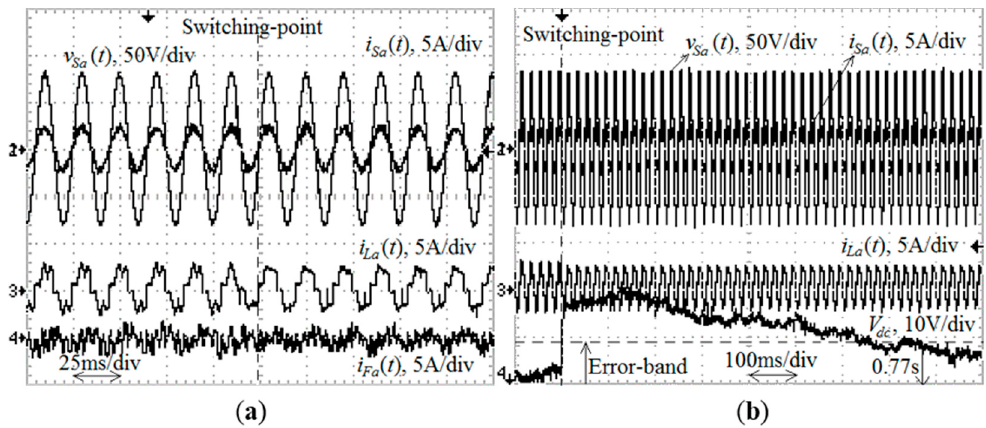
Figure 19. Experimental dynamic ‐ state ( a ) (cid:1874) (cid:3020),(cid:3036)(cid:3028) (cid:4666)(cid:1872)(cid:4667) , (cid:1861) (cid:3020),(cid:3036)(cid:3028) (cid:4666)(cid:1872)(cid:4667) , (cid:1861) (cid:3013),(cid:3036)(cid:3028) (cid:4666)(cid:1872)(cid:4667) , (cid:1861) (cid:3007),(cid:3036)(cid:3028) (cid:4666)(cid:1872)(cid:4667) , and ( b ) 3 ‐ phase (cid:1861) (cid:3020) (cid:4666)(cid:1872)(cid:4667) Figure 19. Experimental dynamic-state ( a ) v S , ia ( t ) , i S , ia ( t ) , i L , ia ( t ) , i F , ia ( t ) , and ( b ) 3-phase i S ( t ) waveforms during the switching between Load 1 and Load 2. waveforms during the switching between Load 1 and Load